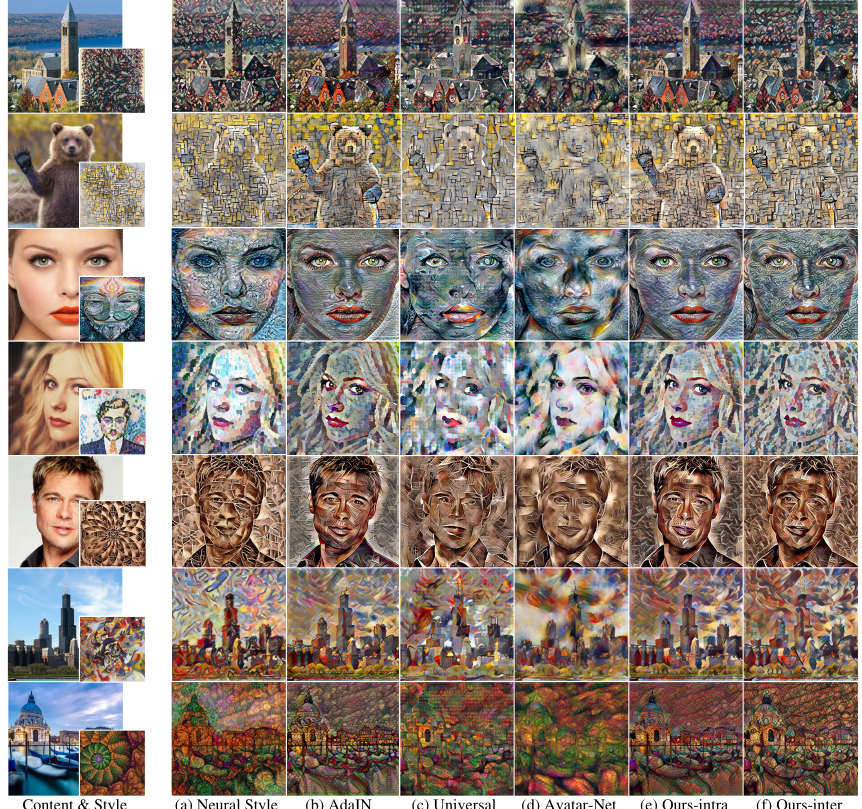
Figure 5. The result images of existing style transfer methods and Ours-intra/inter based on the VGG 19 feature network: The target content images and style images were not used during network